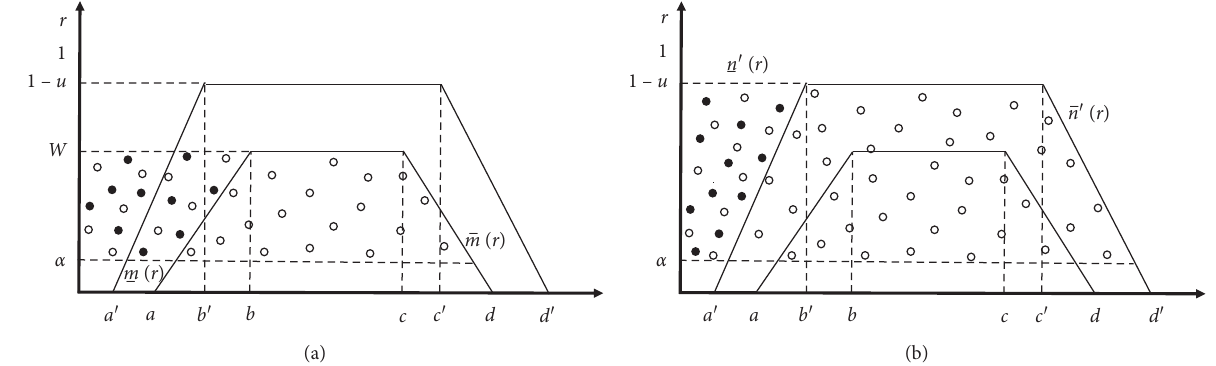
Figure 6: The geometric representation of S